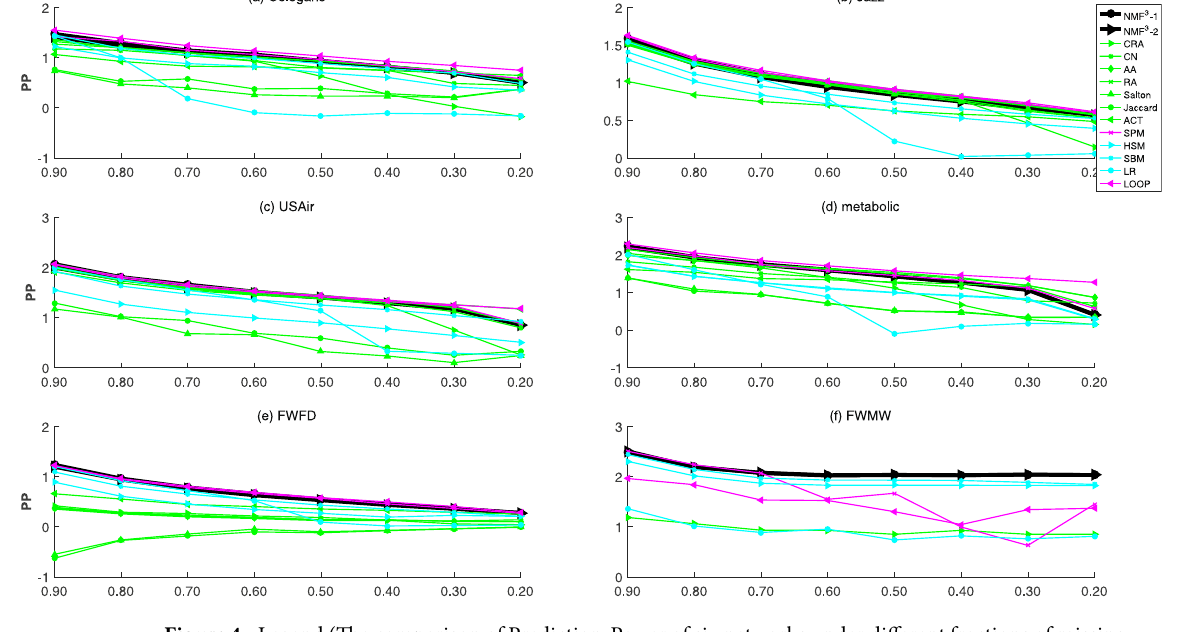
Figure 4. Legend (The comparison of Prediction-Power of six networks under different fractions of missing links. Besides our kernel framework ( NMF 3 − 1, NMF 3 − 2), we further compare our methods with eight well- known methods (AA, RA, CN, Salton, ACT, Jaccard, CRA, SPM, HSM, SBM, LP, LOOP). Each data point is averaged over 100 independent